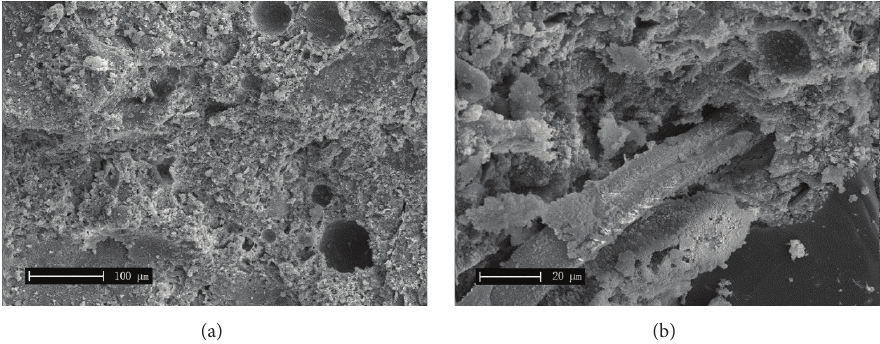
Figure 7: SEM images of microstructure of CFRC exposed at 300 ∘ C for 4h at (a) 500x and (b) 2000x magnification.